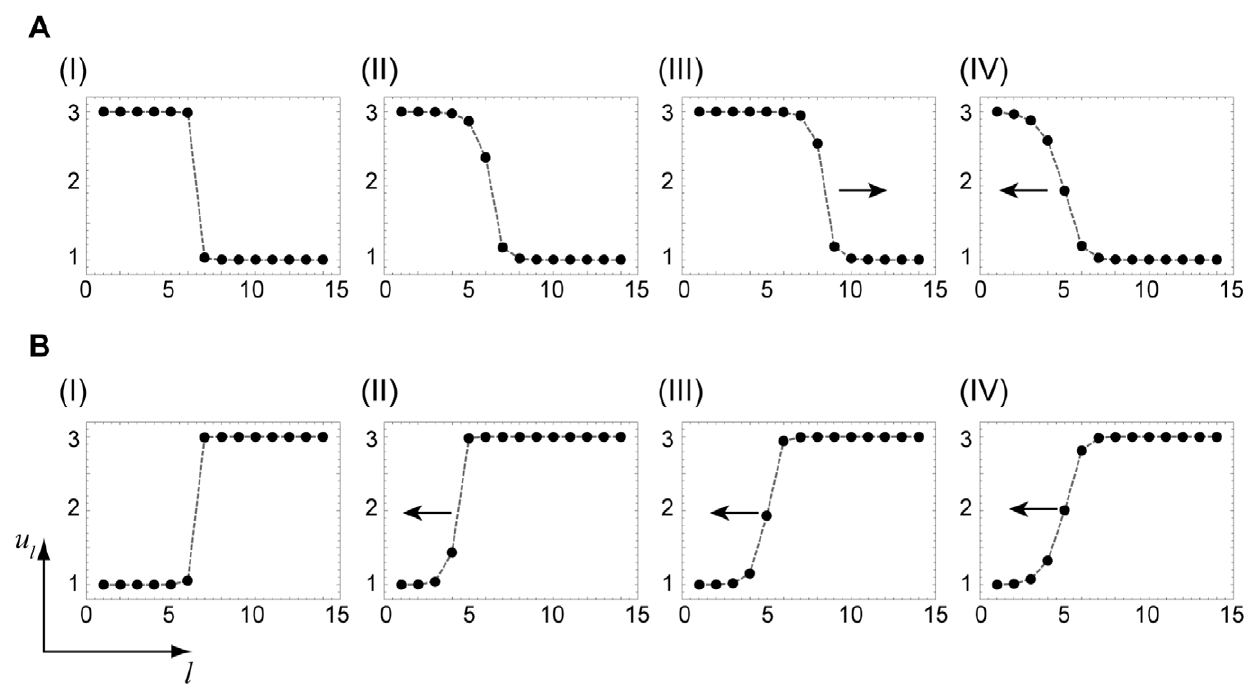
Figure 9. Stationary and traveling fronts in regular trees. The arrows show the propagation direction for traveling fronts. The labels refer to different regions of the bifurcation diagram in Fig. 7. They correspond to the parameter values (I) k ~ 3, D ~ 0 : 01 , (II) k ~ 6, D ~ 0 : 03 , (III) k ~ 3, D ~ 0 : 1 and (IV) k ~ 12, D ~ 0 : 1 . The other parameters are r 1 ~ 1, r 2 ~ 1 : 4 and r 3 ~ 3 .